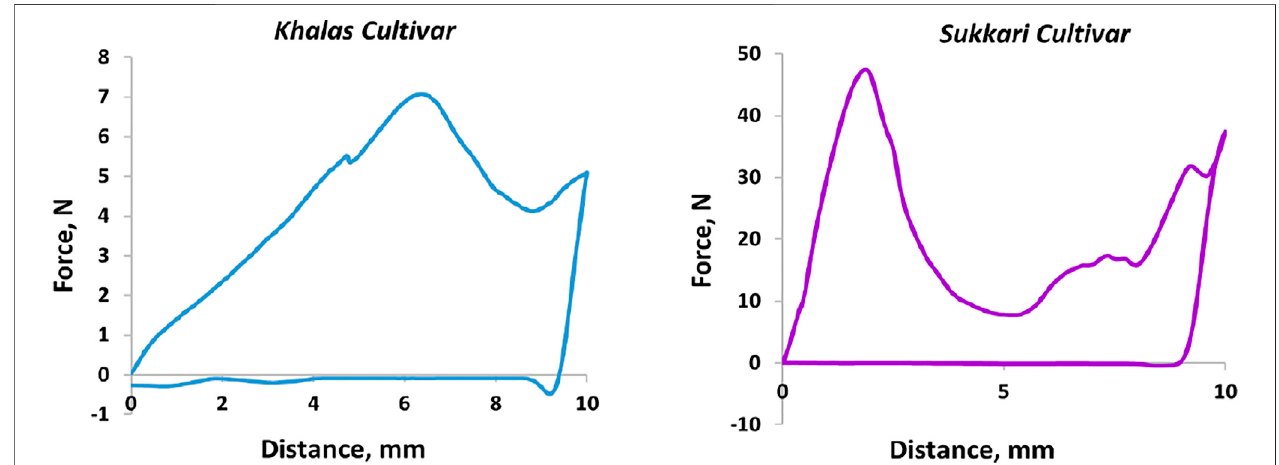
FIGURE 5 | Variation in the force behavior curve among Khalas and Sukkari cultivars.